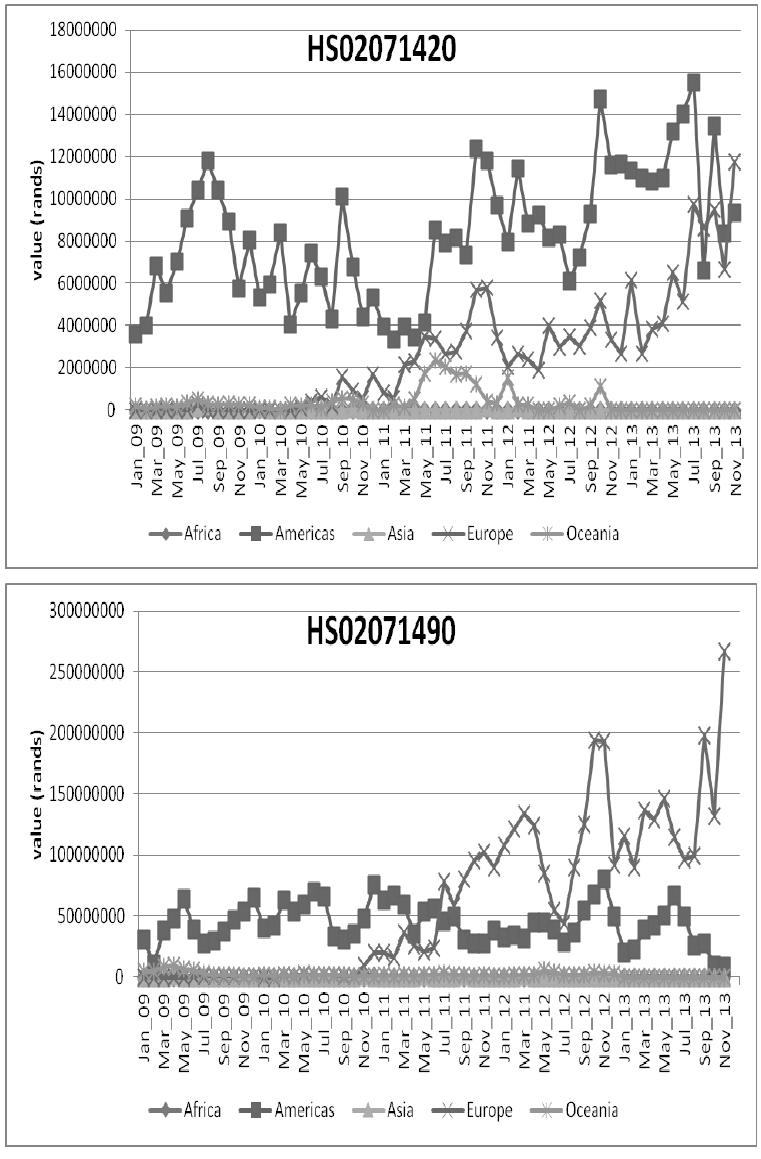
FIGURE 6: Trends in import structure of offal and other bone-in portions across continents Source: Data from Quantec,